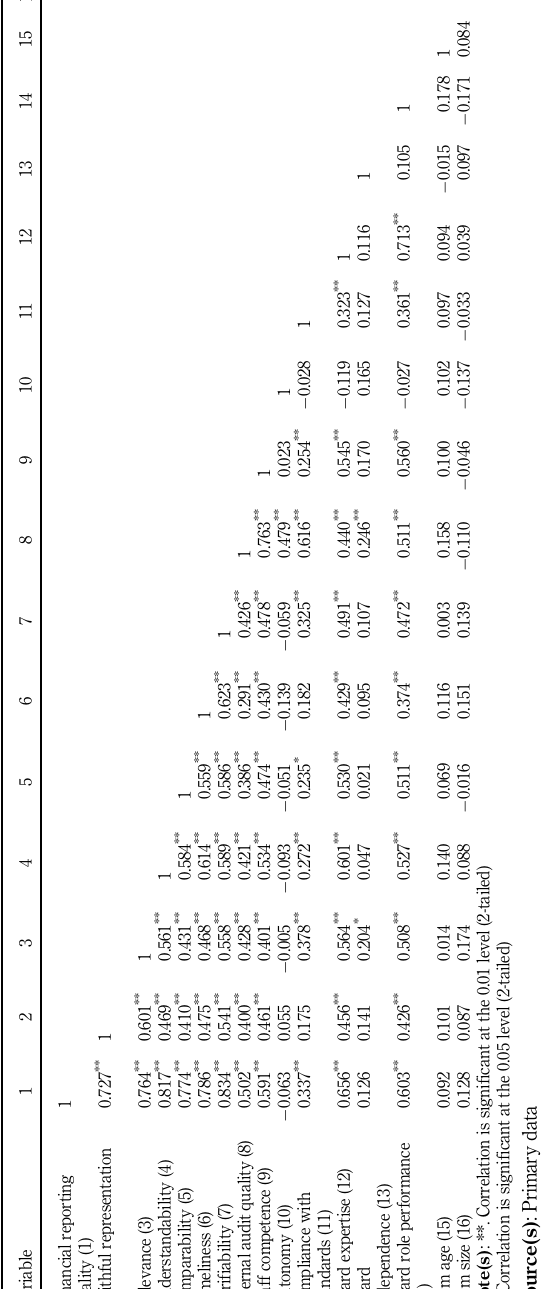
Table 4. Correlation analysis